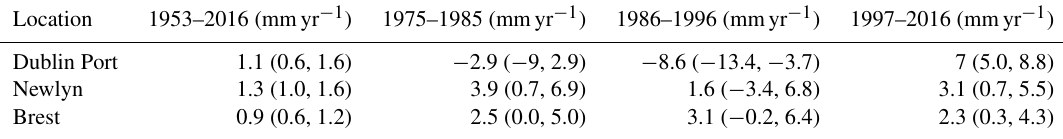
Table 5. Estimated rates of SLR at Dublin Port, Newlyn and Brest, with 95% credible intervals for the time periods of interest.